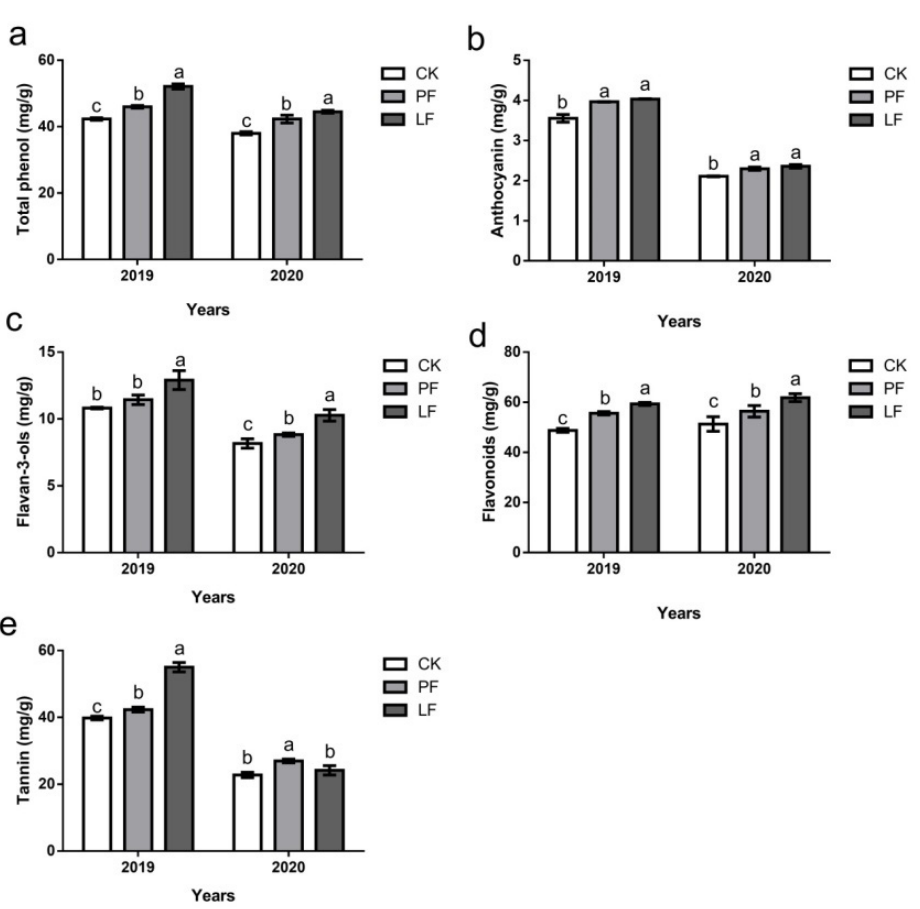
Figure 9. Effects of in-row mulching on the content of polyphenols in grape skins in 2019 and 2020. ( a ): Total phenol; ( b ): Anthocyanin; ( c ): Flavan-3-ols; ( d ): Flavonoids; ( e ): Tannin. Different letters above the columns indicate significant differences between treatments in Duncan’s multiple comparisons ( p < 0.05) .